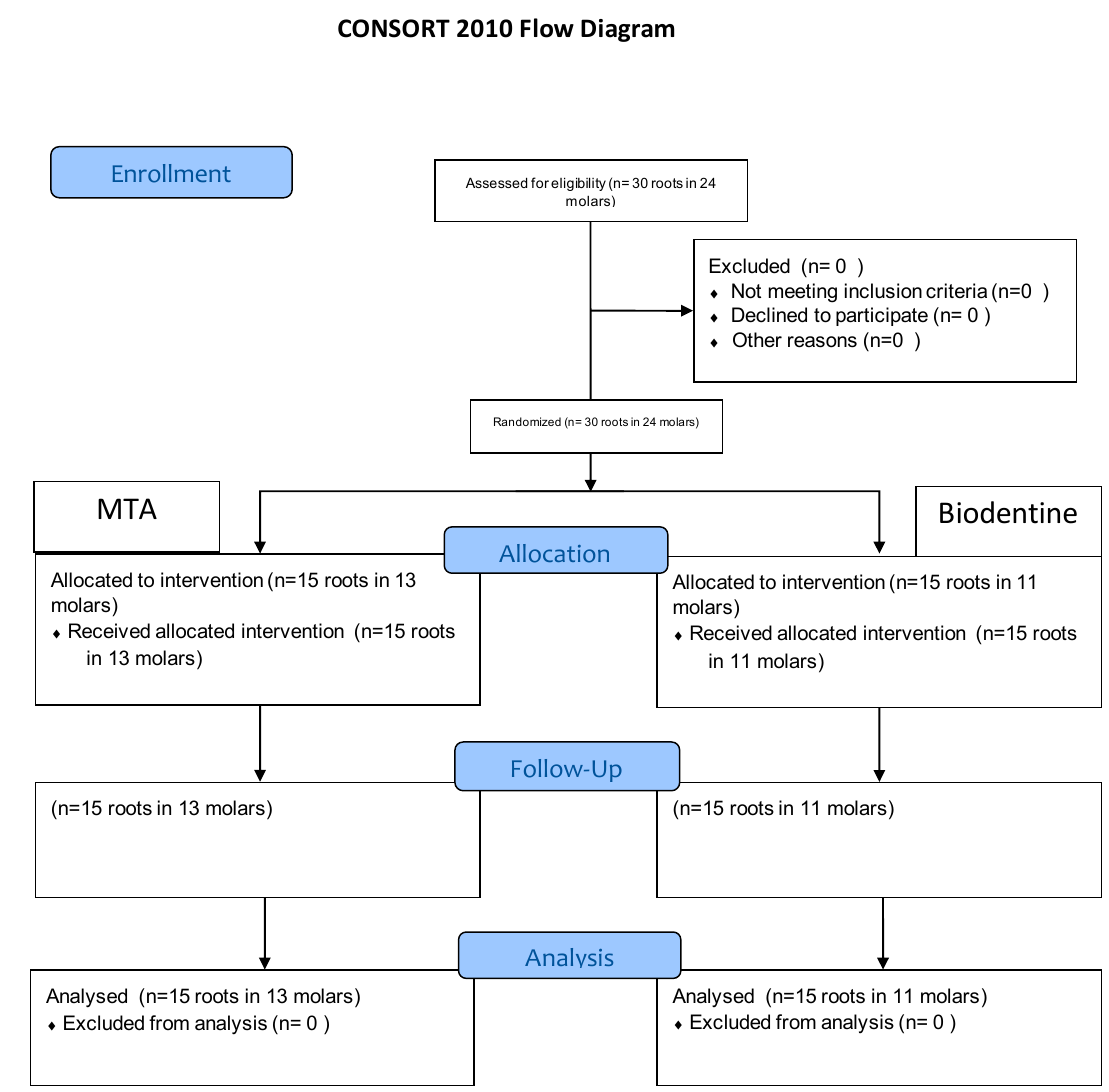
Figure 6. Flow chart for the study.